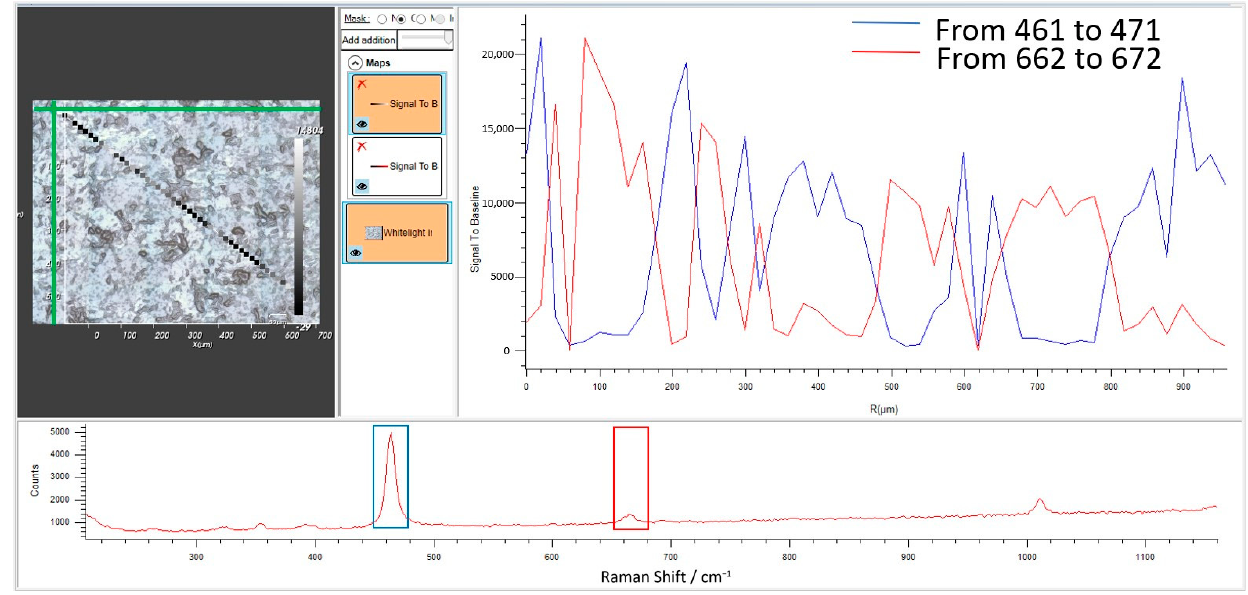
Figure 7. micro-Raman spectroscopy—line map tool applied for a green stone characterization, a diopside-quartzite rock, reported as an example of the technique’s feasibility. ( Top-left ) MO image (20× magnification, reflected light) showing the mapping area on the sample surface and also the analyses spots; ( Top-right ) data results elaborated by signal to baseline method, considering the two ranges, corresponding to the main vibrational modes of diopside (red line) and quartz (blue line). Note the complementarity of the main bands’ distribution related to the sample area where the signals have been detected, highlighted by the graph; ( bottom ) one of the spot analysis results, corresponding to the cross axes spot in the map image (green): blue and red squares correspond to the quartz and diopside main vibrational mode ranges, used for the elaboration. The map has been carried out using In-Via Confocal micro-Raman Spectroscope, Renishaw, 514.5 nm source, Wire 5.5 software. Data: M. Musa, GIG.